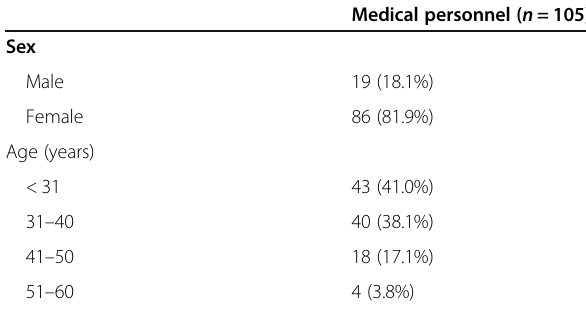
Table 1 Demographics of patients who received